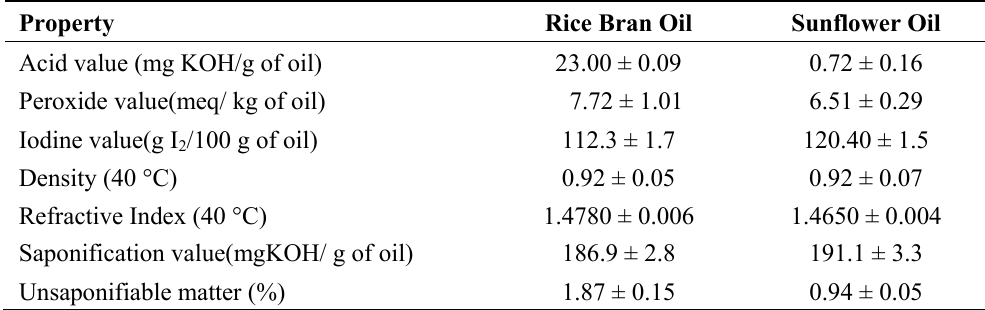
Table 1. Physico-chemical characteristics of different feedstock used for biodiesel production. Property Rice Bran Oil Sunflower Oil Acid value (mg KOH/g of